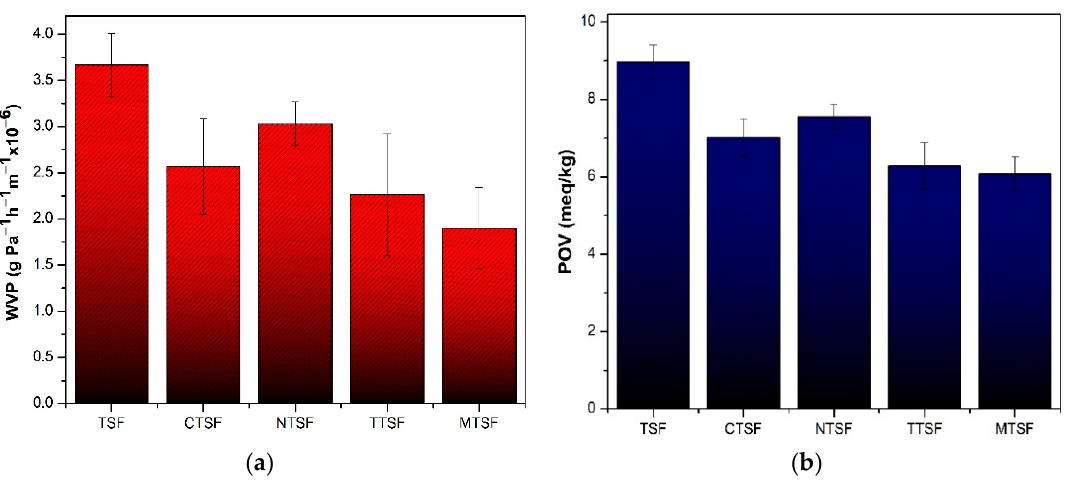
Figure 3. ( a ) WVP and; ( b ) OP of biodegradable composite films with and without plant